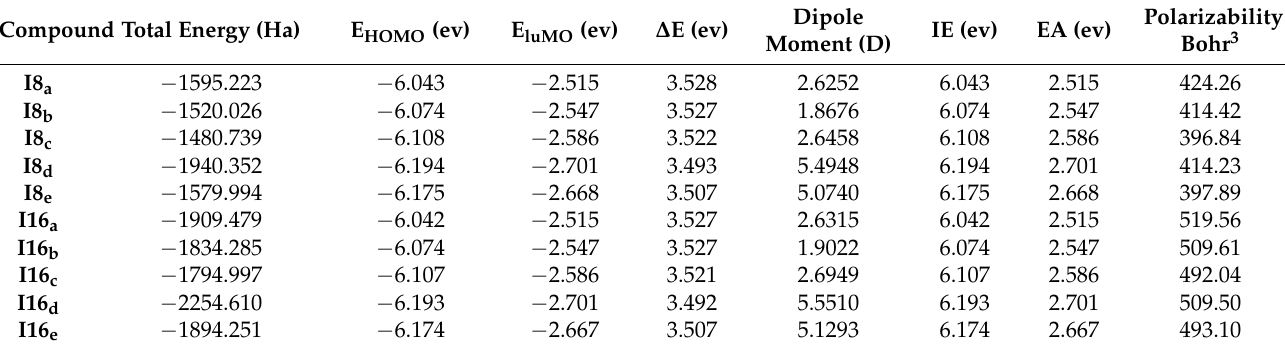
Table 3. Total Energy, E HOMO , E LUMO , ∆ E, dipole moment, ionization energy, electron affinity, and polarizability for the investigated series, In x .